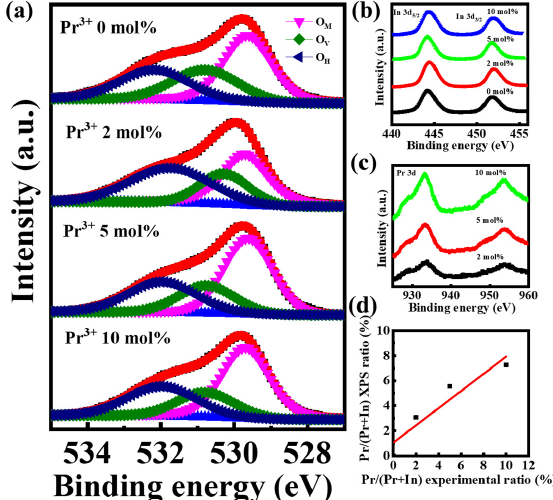
Figure 7. X-ray photoelectron spectroscopy spectra for In-Pr-O films with indicated Pr concentrations. ( a ) O 1s, ( b ) In 3d, ( c ) Pr 3d, and ( d ) Pr doping ratio between solution and thin film.